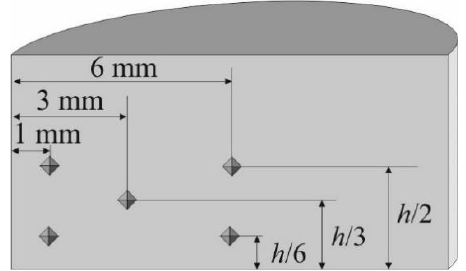
Figure 4. Microhardness indentation map on a compact diametrical section. All the measured values were averaged to determine the hardness of the whole specimen.